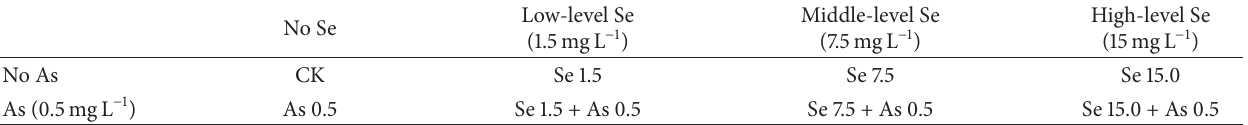
Table 1: Experimental design of the metabolic process of the isolated bacteria on Se and As.